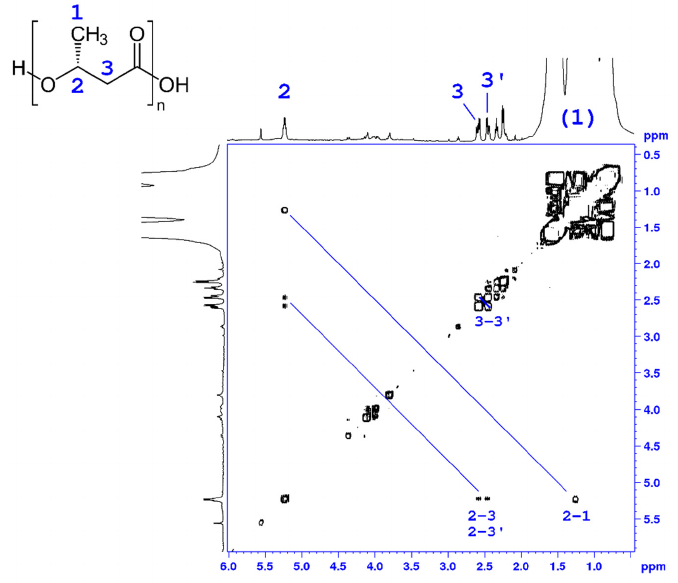
Figure 6. Homonuclear 1 H- 1 H 2D gCOSY NMR spectrum of isolated PHB produced by Pseudomonas sp. phDV1 grown in M9 minimal media supplemented with 600 mg/L phenol as the sole carbon source. The spectrum was recorded in CDCl 3 solution at 500.13